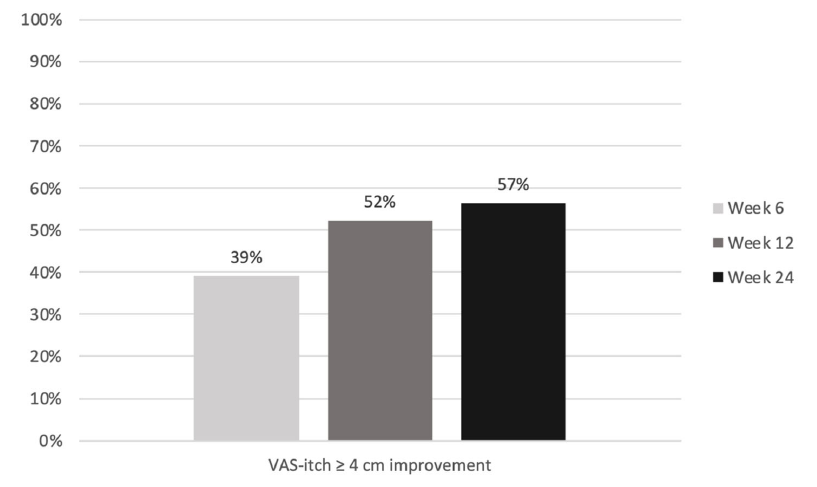
Figure 3. Percentage of patients with a clinically significant improvement of at least 4 cm in the VAS-itch. VAS-itch.